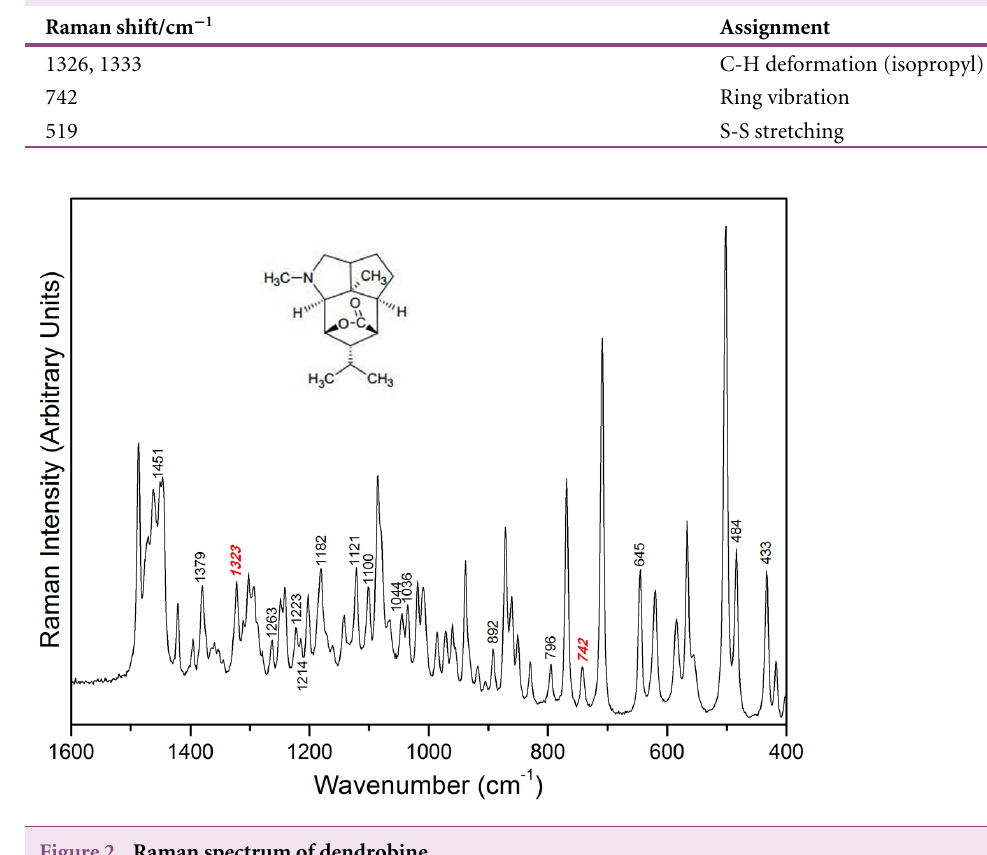
Figure 2 Raman spectrum of